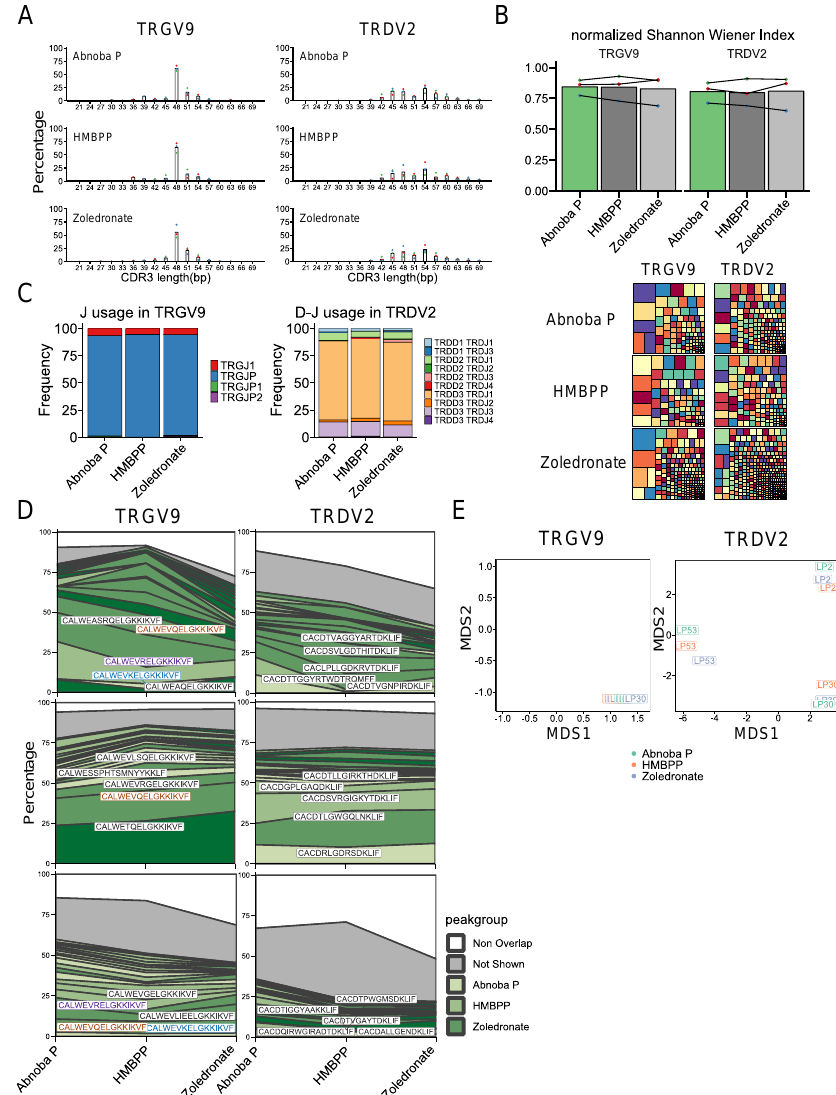
Figure 4. The AbnobaViscum-responsive V γ 9V δ 2 TCR repertoire is similar to the phosphoantigen-responsive repertoire. ( A ) Distribution of CDR3 length for TRGV9- and TRDV2-containing CDR3 sequences after expansion with the indicated V γ 9V δ 2 T cell stimulators. Each color of the dots represents the same subject, bar indicates mean percentage for each CDR3 length (expressed in nucleotides). ( B ) Diversity of TRGV9- and TRDV2- containing CDR3. Normalized Shannon Wiener index: each color of the dots represents the same subject, lines connect each subject, bars indicate mean value. Representative treemaps for the indicated stimulators are below the graphs: each small square represents a CDR3 sequence of which the size is related to the frequency of the sequence within the repertoire within each sample (rectangle colors are chosen randomly and do not match between plots). ( C ) Mean J gene segment usage in TRGV9-containing CDR3 (left) and mean D-J gene segment usage in TRDV2-containing CDR3 sequences (right) ( n = 3). ( D ) Sequence overlap between AP-, HMBPP- and zoledronate-induced expansions for TRGV9-containing CDR3 (left) and TRDV2-containing CDR3 (right). The top 20 sequences are filled with di ff erent green shades, the remaining overlapping sequences are indicated in grey and the non-overlapping sequences are in white. Top 5 shared sequences are provided on the plots for each subject: colored sequences occur in more than one subject while black sequences indicate unique sequences. ( E ) Multidimensional scaling analysis of TRGV9-containing CDR3 sequences (left) and TRDV2-containing CDR3 sequences (right). Colors indicate each expansion; the subject number is indicated within each small